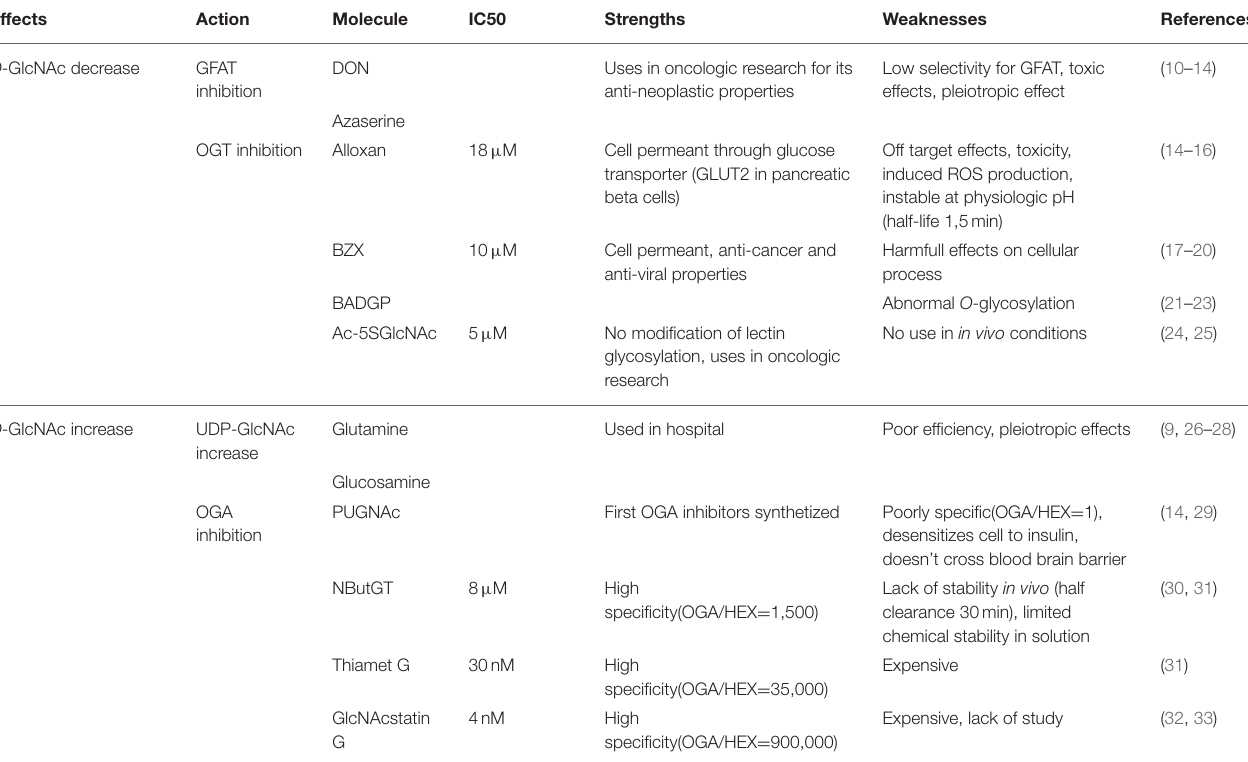
TABLE 1 | Summary of molecules currently available for O- GlcNAc level modulation: their actions, specificity, known limits and